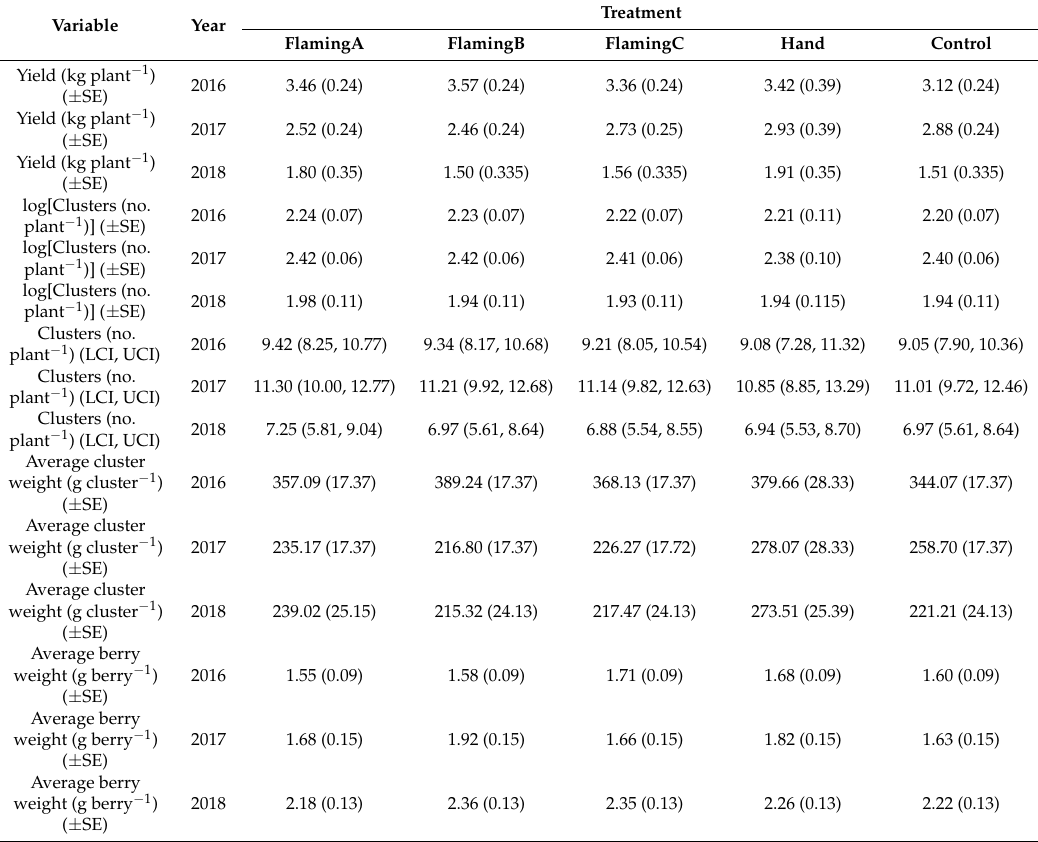
Table 5. Least squares means and standard errors of the yield, clusters number (log transformed) average cluster weight and average berry weight as affected by the type of treatment and the year. Inverse transformed values and lower and upper 95% confidence intervals (LCI, UCI) of clusters number log transformed are